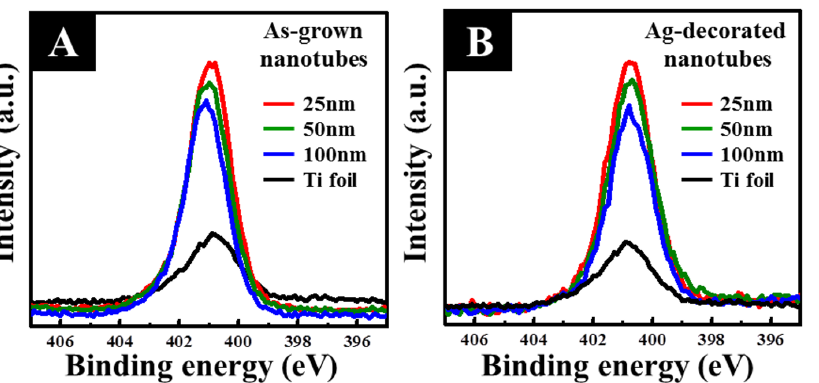
Figure 11. XPS surface analysis results, in terms of spectra for N 1s of the as-grown and Ag-decorated TiO 2 nanotubes. All nanotube samples of different diameters, either as-grown or Ag decorates series, had much higher N 1 s intensity than the plain Ti